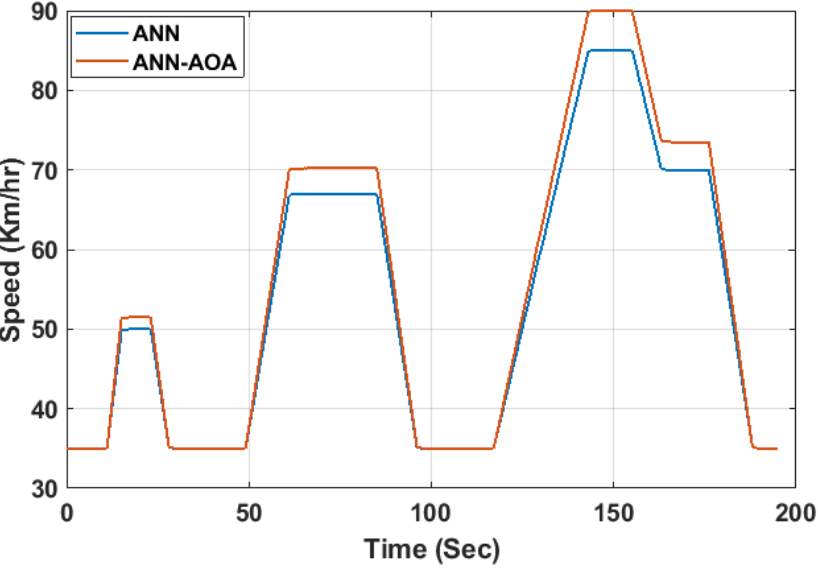
Figure 15. Analysis of vehicle speed with ANN and ANN–AOA.